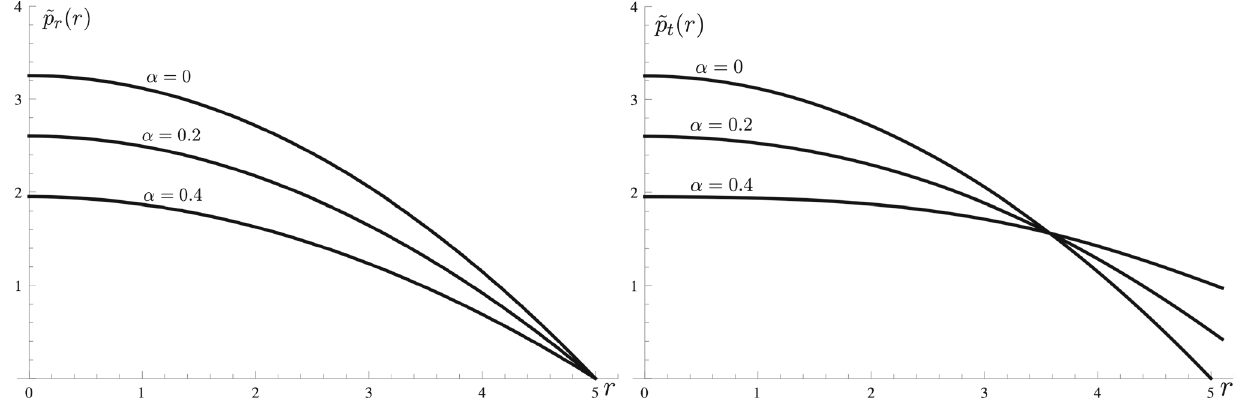
Radial coordinates are in units of M ( r = 5 = R ) . The cosmological constant (cid:5) ∼ 10 − 52 is too small to be relevant